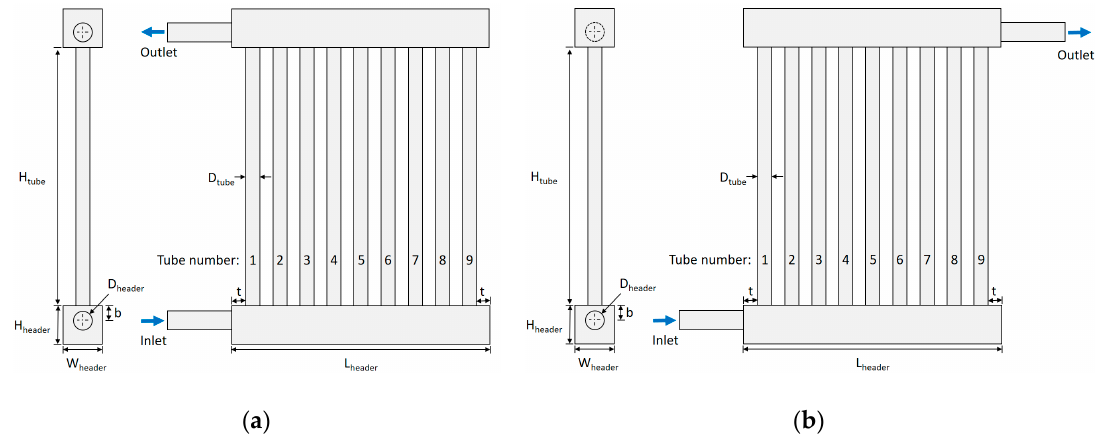
Figure 1. Schematic of conventional parallel-flow heat exchangers: ( a ) U-type; ( b ) Z-type.